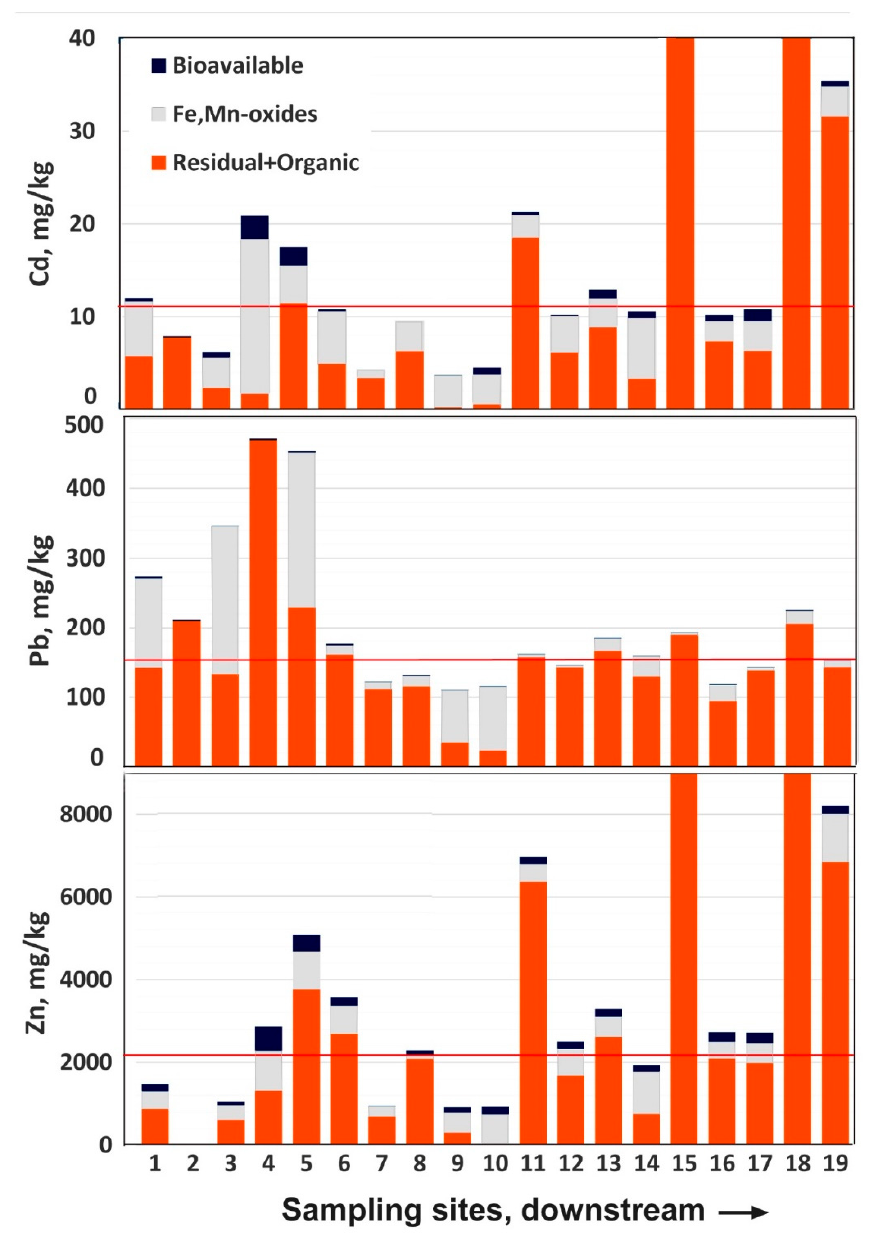
Figure 4. Total content of Cd, Pb, and Zn in Turkey Creek sediments and their fractionation into bioavailable, Fe-oxides, and organic/residual phases. The red line corresponds to the metal concentration identified by toxicology studies as probable effect concentration (PEC) [15].